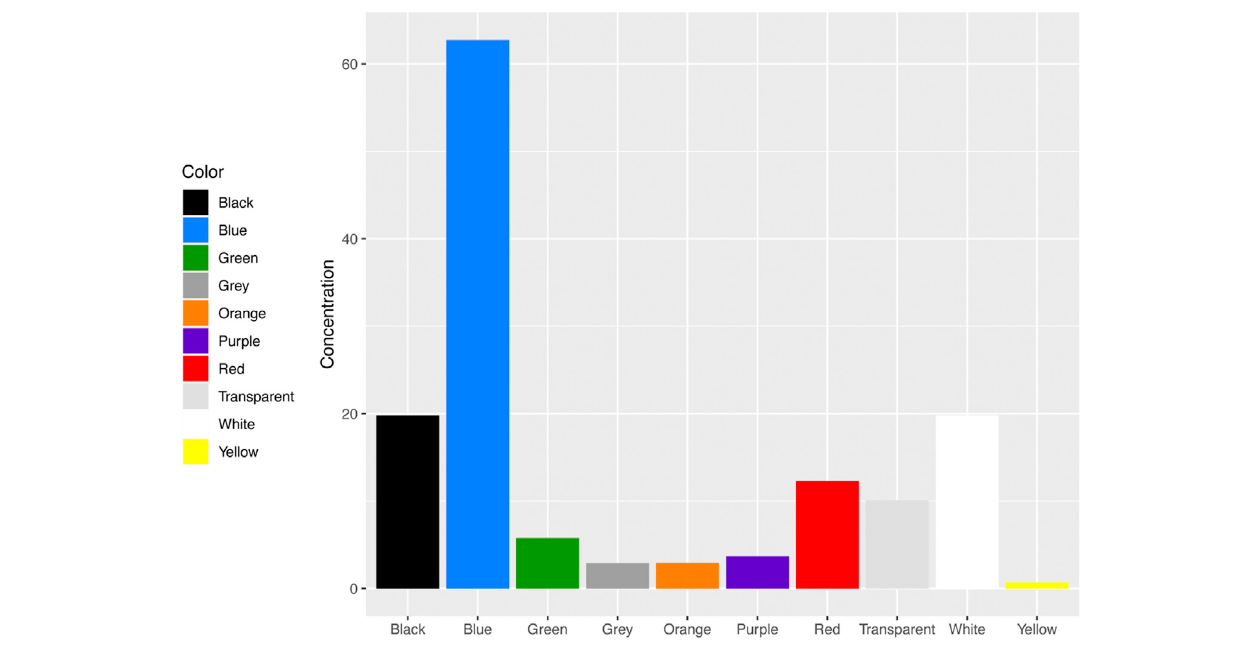
FIGURE 8 | Microplastics concentration (items/m 3 ) according to colors for combined data from the marine areas of Beirut and Tyre.